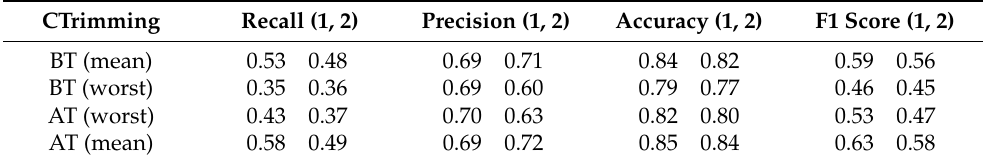
Table 6. Four performance results of GRU with training data type